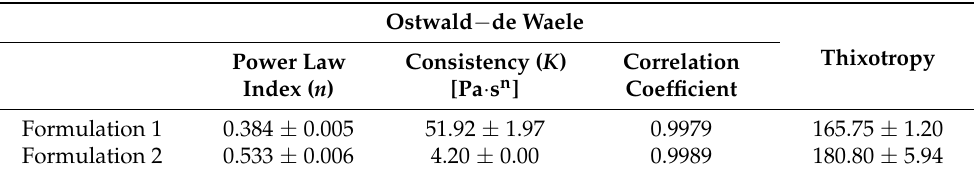
Table 5. The calculated rheological parameters from the course of the flow-curves. Ostwald − de Waele ThixotropyPower